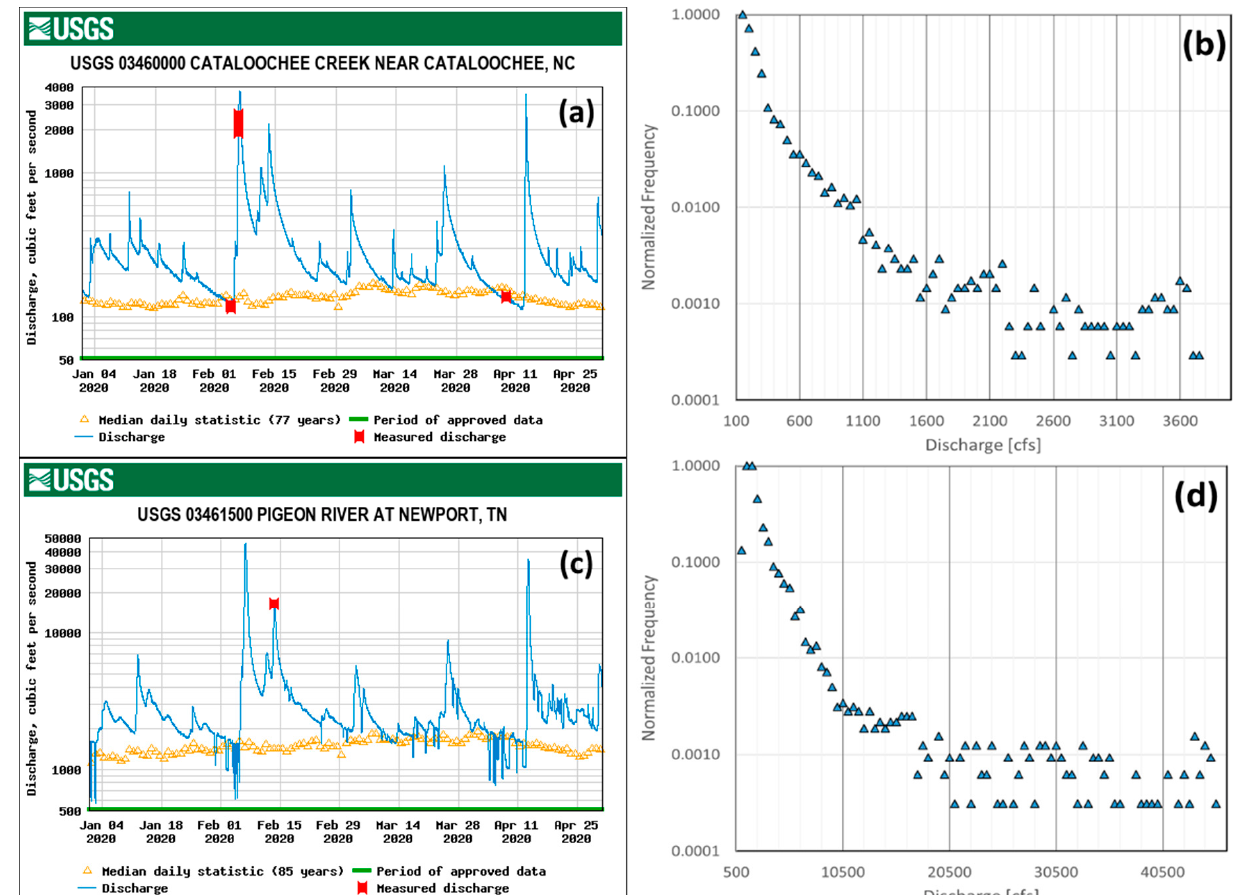
Figure 2. USGS discharge (cfs) hydrographs ( a ) at Cataloochee Creek near Cataloochee, North Carolina, and ( c ) at the Pigeon River at Newport, Tennessee over the 1 January–30 April 2020 period and corresponding histograms ( b ) and ( d ) (accessed online https://waterdata.usgs.gov/nc/nwis/rt and https://waterdata.usgs.gov/tn/nwis/rt, accessed on 5 June 2021). Histogram bin size for panel ( b ) and ( d ) is 50 and 500 cfs, respectively.